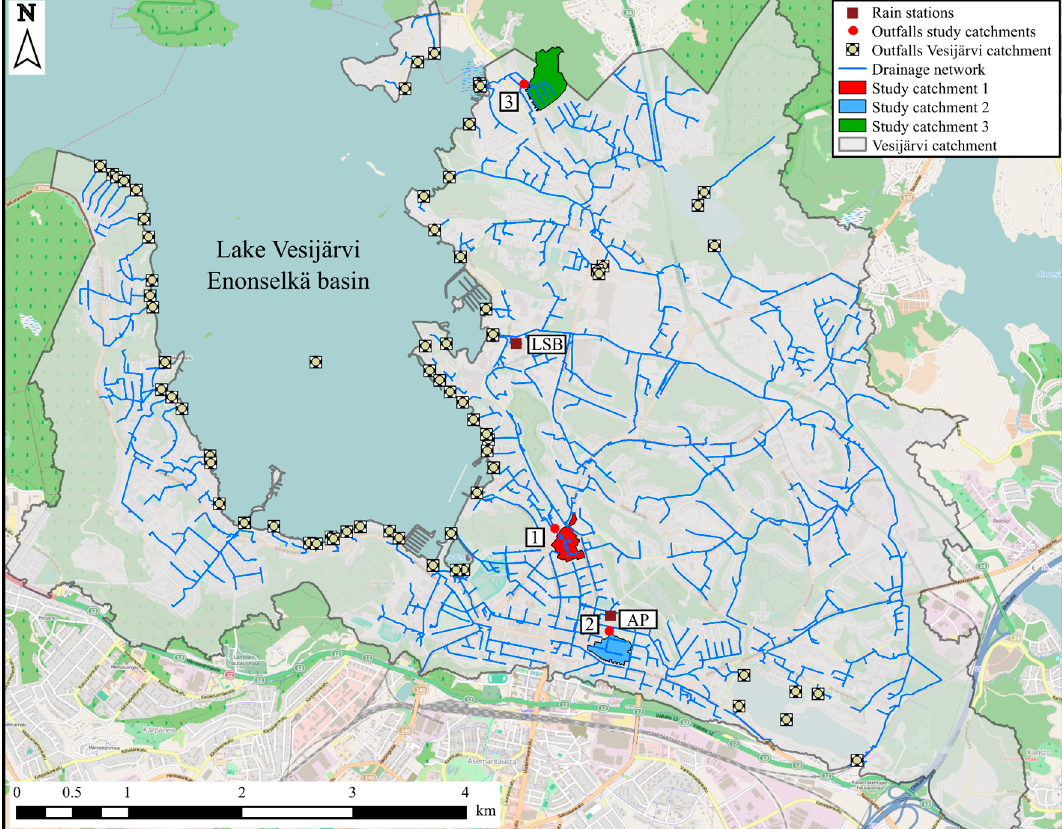
Figure 1. The Vesijärvi catchment of the city of Lahti, the drainage network (conduits with a diameter ≥ 300 mm and open channels), and the outfalls of the system to the receiving water bodies. The monitored study Catchments 1, 2, and 3 along with their outfalls and the two rainfall stations (AP and LSB) are shown.